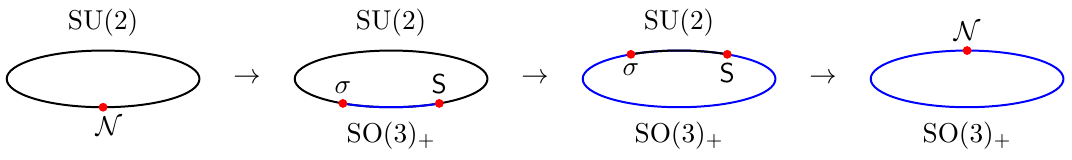
Figure 3 . Twisted compactification of SU(2) SYM and SO(3) + SYM by the non-invertible defect N gives the same theory in three dimensions. This can be seen by splitting and moving the topological defects in the manner shown